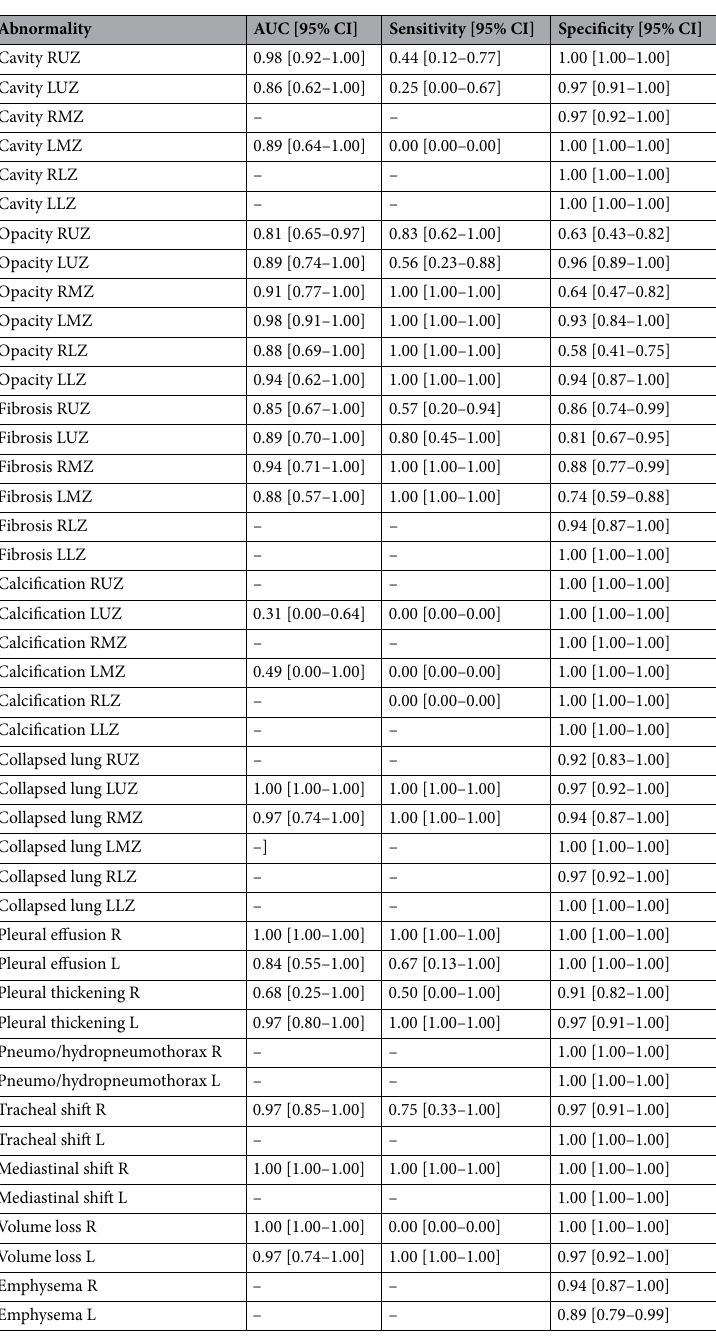
Table 5. Estimates of diagnostic metrics of lung zone wise abnormalities in EfficientNetB4 model in external test set. 95% CI for AUC calculated using Hanley & McNeil method. 95% CI for sensitivity and specificity calculated using Wilson Score method. – indicate no abnormalities found. AUC area under the receiver operating characteristic, RUZ right upper zone, RMZ right mid zone, RLZ right lower zone, LUZ left upper zone, LMZ left mid zone, LLZ left lower zone, R right lung, L left lung, CI confidence